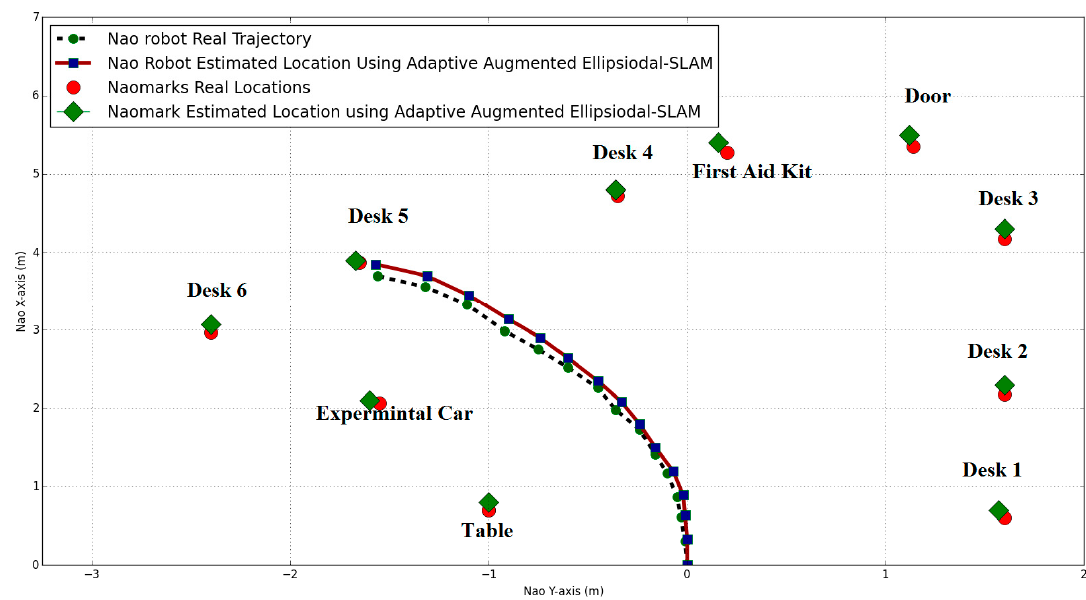
Figure 19. NAO location and NAO marker positions using adaptive augmented ellipsoidal SLAM.